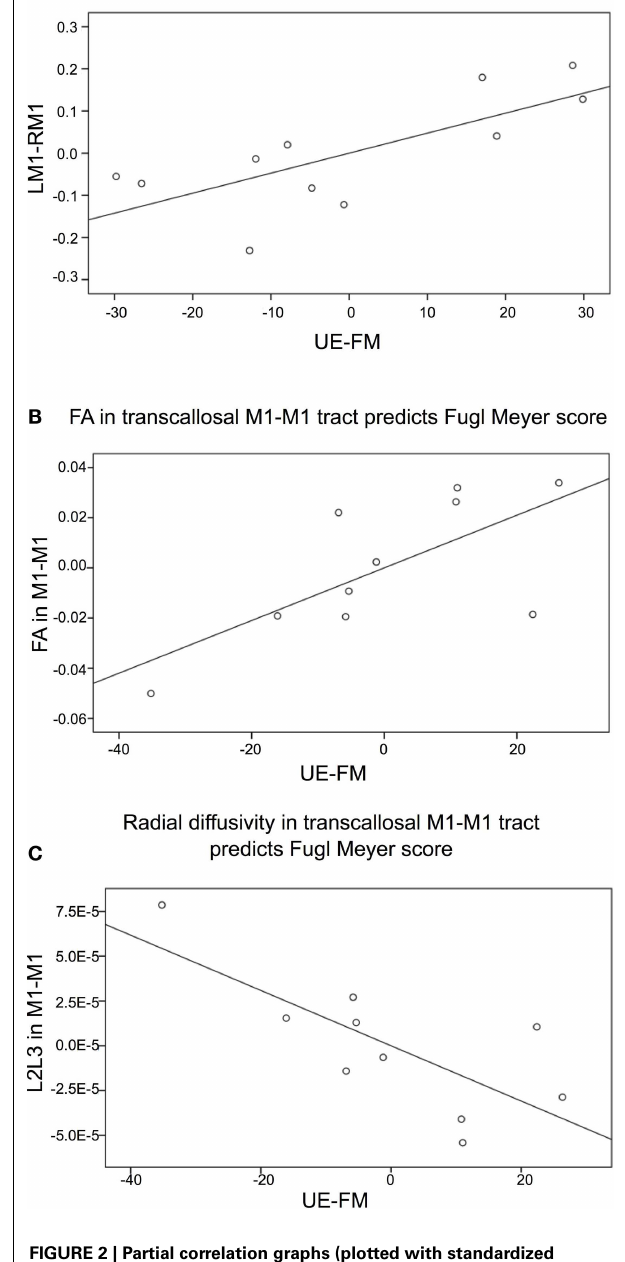
encompassing the ipsilesional (L) posterior limb of the internal capsule (PLIC) and the ipsilesional cerebral peduncle, and